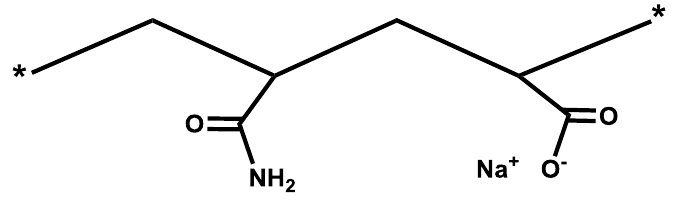
Figure 1. The copolymer of acrylamide and sodium acrylate (HPAM).